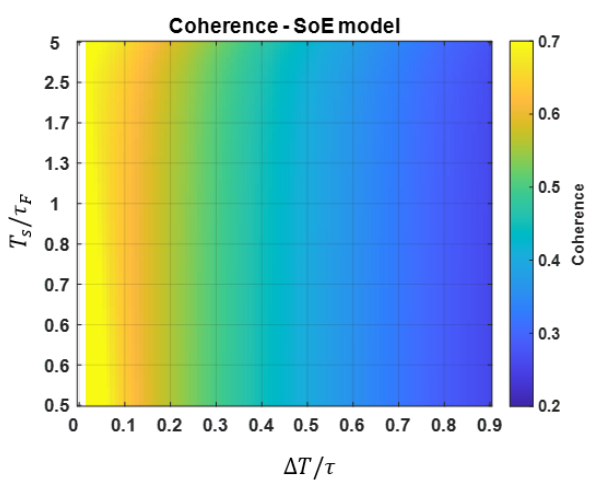
Figure 13. Expected coherence level as a function of the repeat pass interval, ∆ T , normalized by the long decay time (horizontal axis), and of the integration time, normalized by the shift decay time (vertical axis).